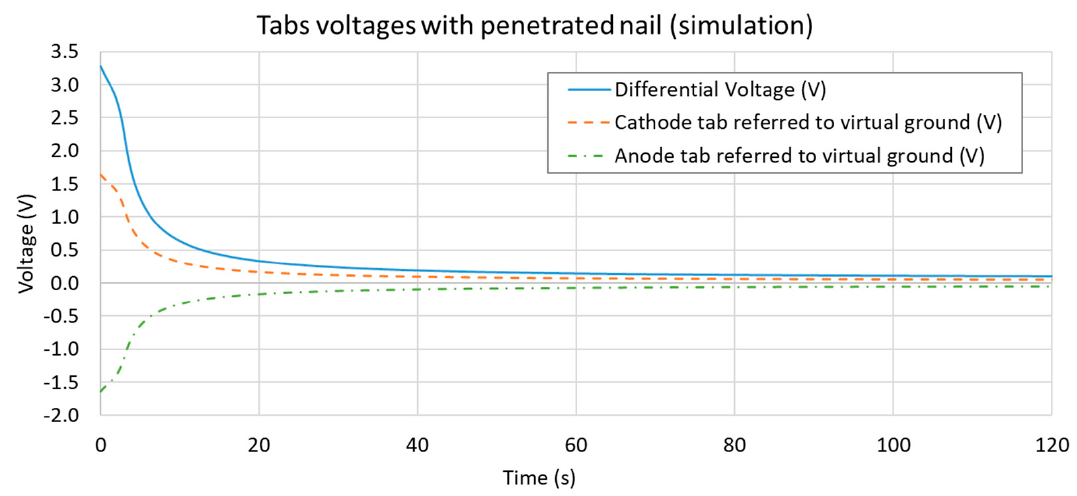
Figure 9. Overview of each tab voltage obtained in the simulation (as compared to a virtual electrical ground state) and the tabs differential value obtained as their difference. Although a boundary condition of 100% SOC (initial differential voltage of 4.2 V) was set, since the nail was simulated already in its final position, the tab voltage dropped to 3.3 V during the first simulation increment.